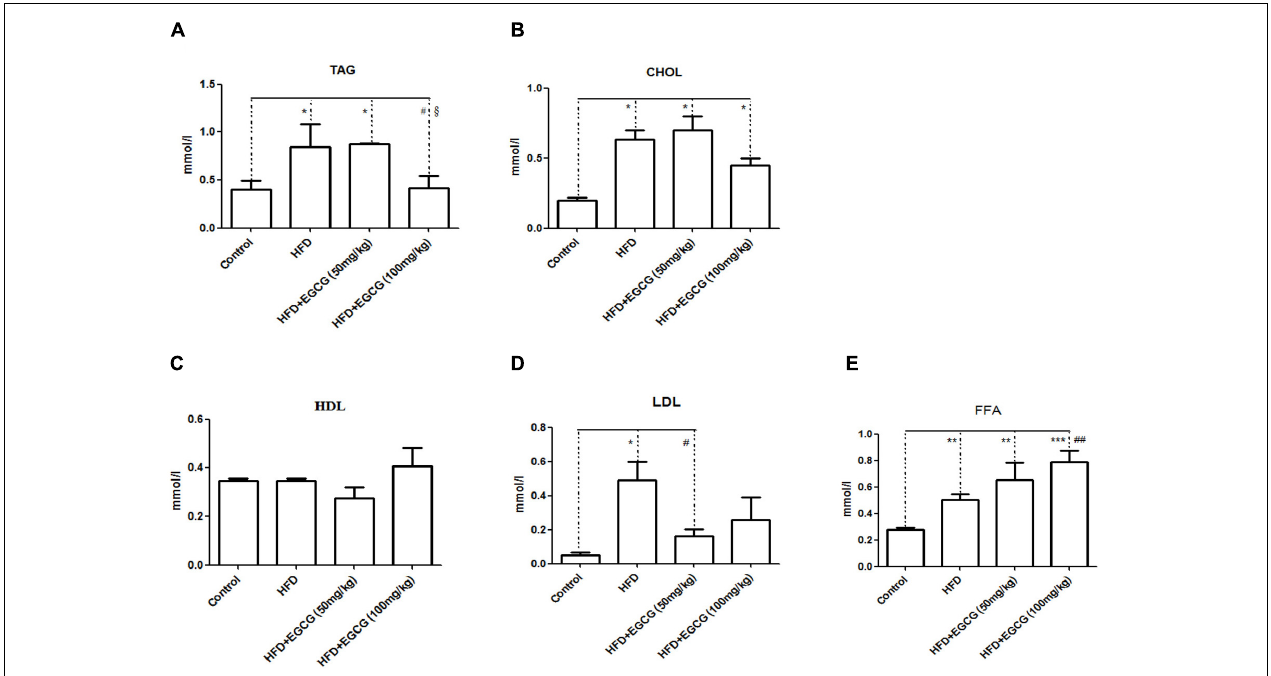
FIGURE 3 | Effect of EGCG on lipid excretion. (A) TAG; (B) CHOL; (C) HDL-C; (D) LDL-C; and (E) FFA. Data were shown as mean ± SEM ( n = 6/7 each group). ∗ P < 0.05; ∗∗ P < 0.01; ∗∗∗ P < 0.001 vs control. # P < 0.05; ## P < 0.01; ### P < 0.001 vs HFD. § P < 0.05 vs HFD + EGCG (50